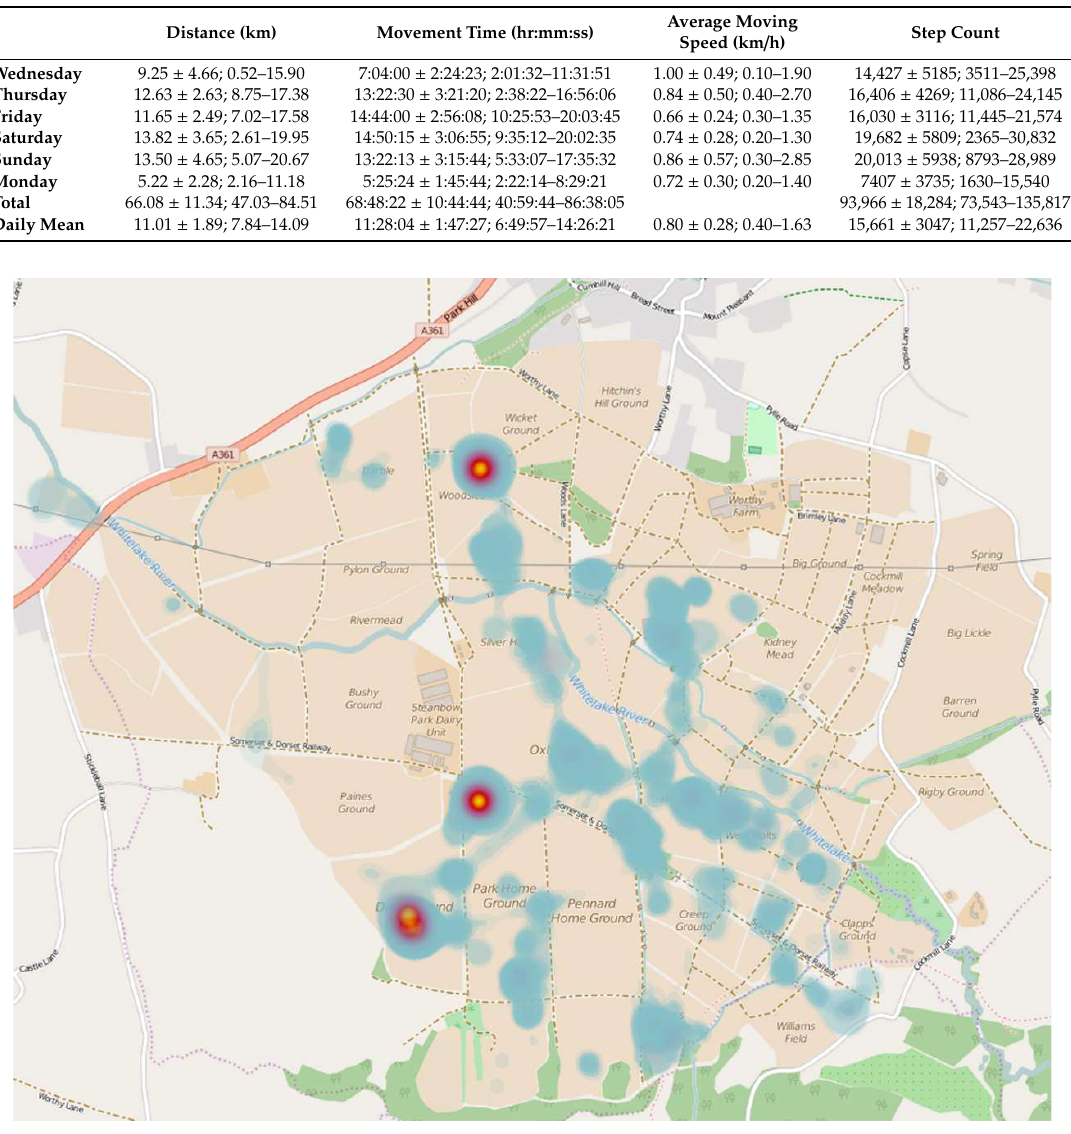
Table 3. Movement data during the festival (Mean ± SD; Range).